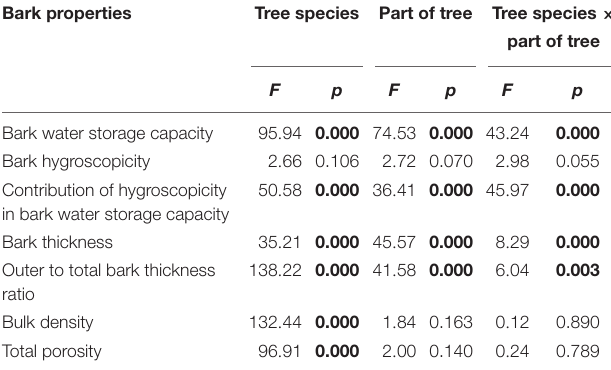
TABLE 2 | General linear model analysis for bark characteristics. Bark